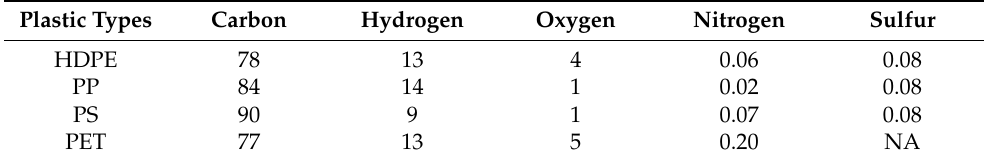
Table 1. Ultimate analysis of different plastic wastes [23].